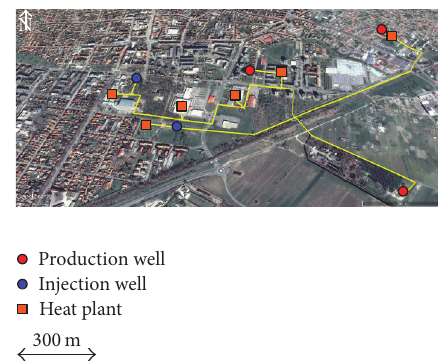
Figure 3: Geothermal cascade system in H´odmez˝ov´as´arhely.